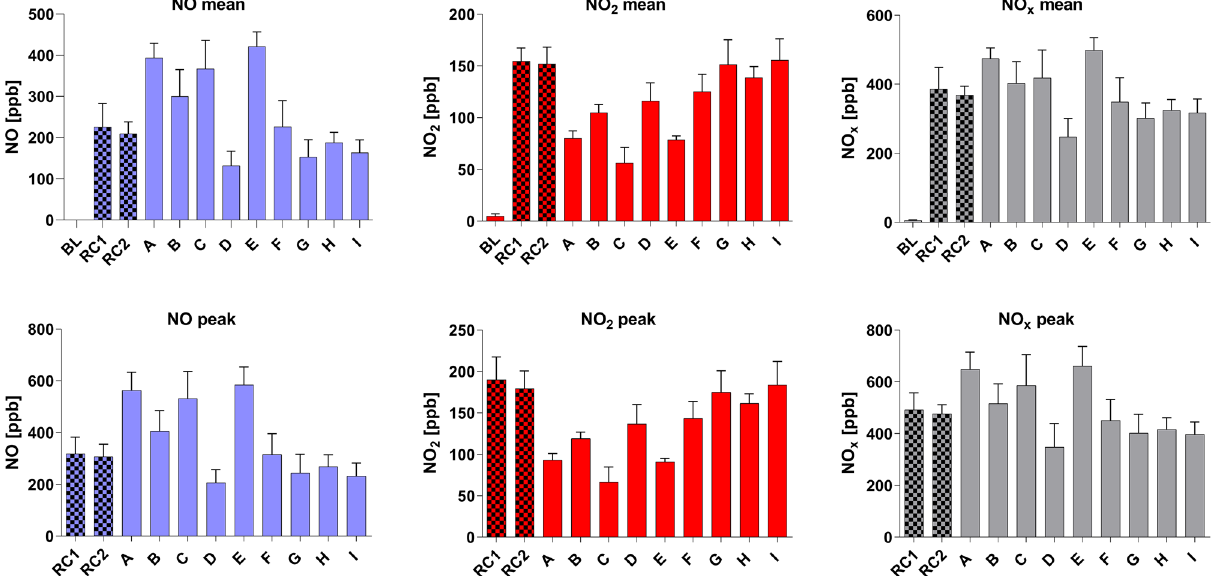
Figure 1. Mean and peak concentrations (ppb) of nitric oxide (NO), nitrogen dioxide (NO 2 ), and nitrogen oxides (NO x ) of the reference cigarette 3R4F (RC1, RC2) and the cigarette brands A to I. Baseline (BL) only given at mean